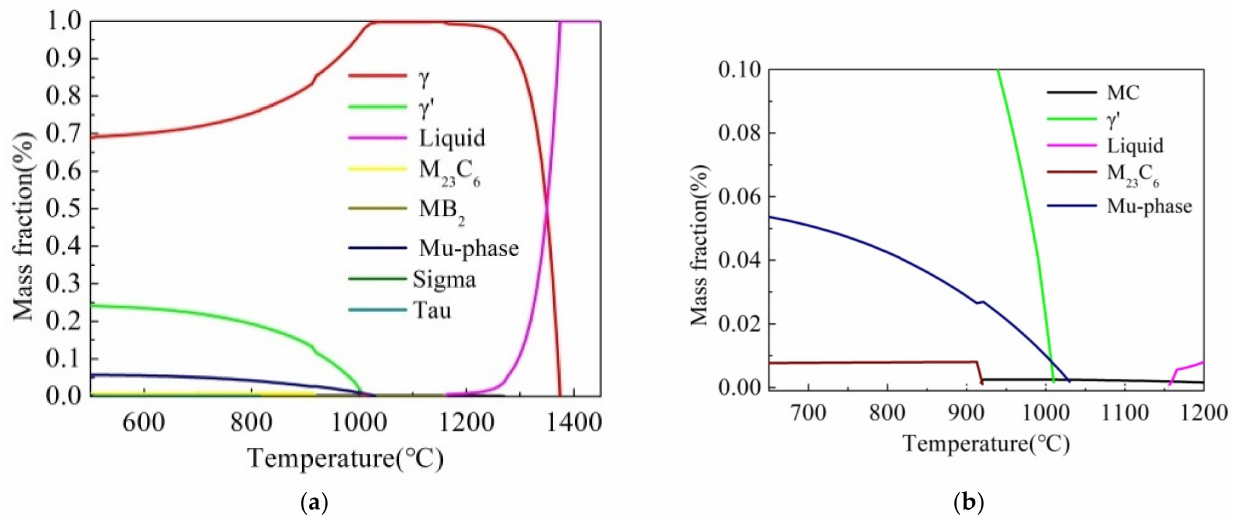
Figure 2. ( a ). Equilibrium phase diagram of the precipitate in the new alloy; ( b ) expansion of the pertinent central region in ( a ).